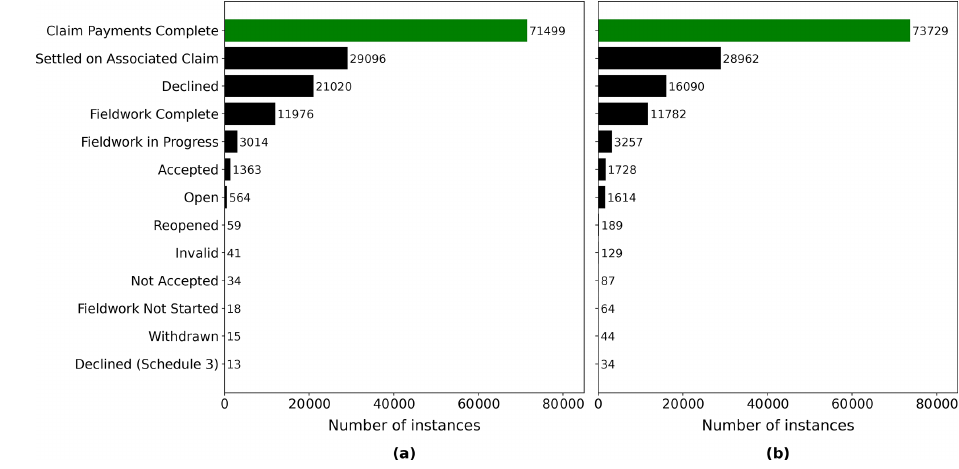
Figure 1. Number of instances grouped by the status of the claim: (a) 4 September 2010 and (b) 22 February 2011.